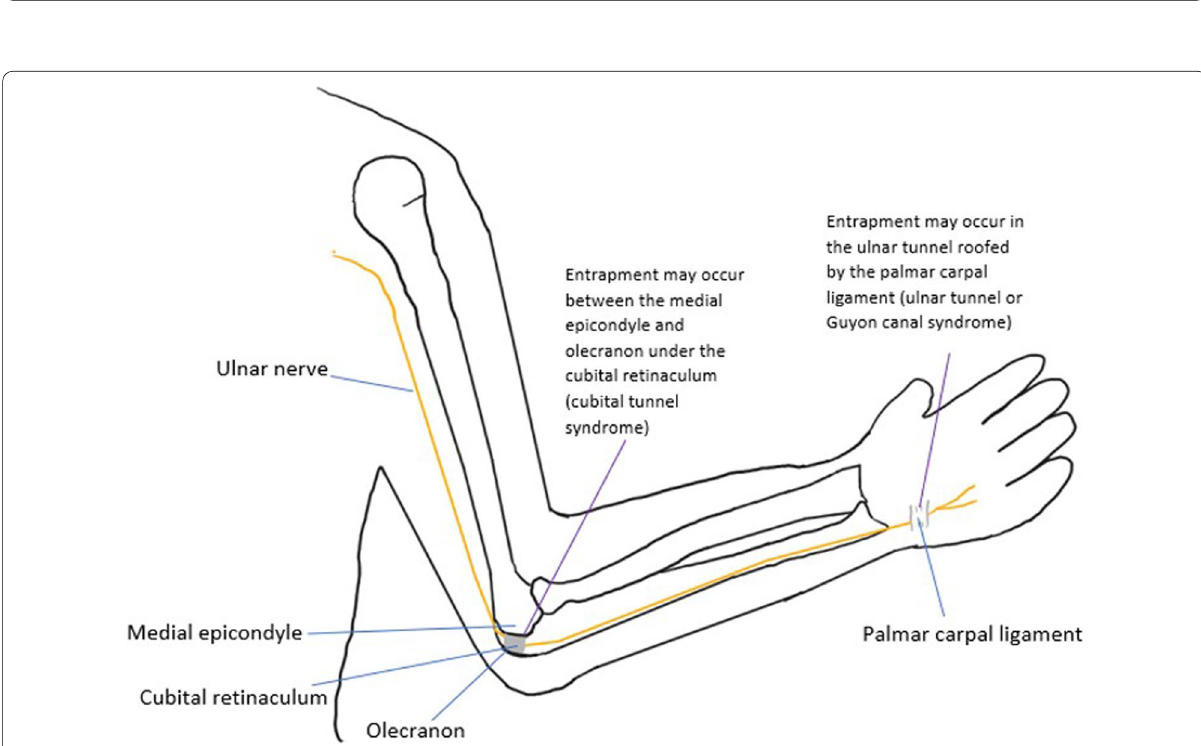
Fig. 14 The ulnar nerve is shown. The most common entrapment neuropathies of the ulnar nerve are the cubital tunnel syndrome at the elbow, and the ulnar tunnel syndrome at the